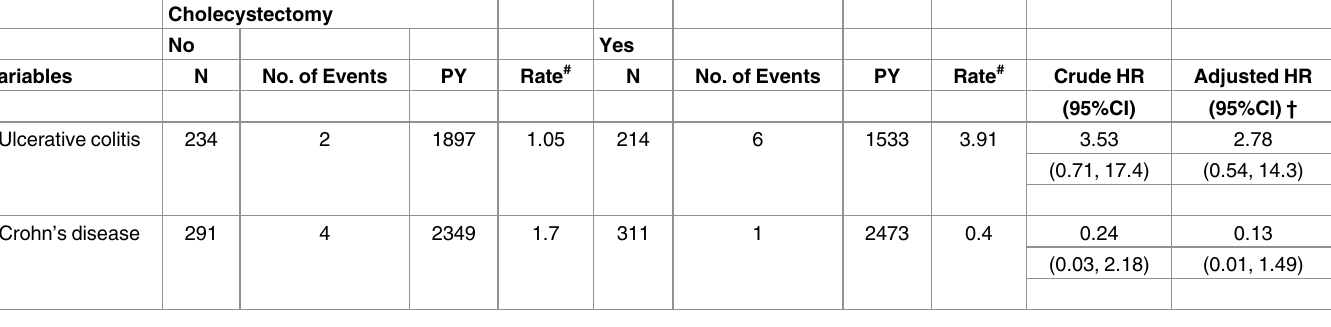
Table 3. Incidence and adjusted hazard ratio of colorectal cancer stratified by different entities of inflammatory bowel disease patients with or without cholecystectomy.